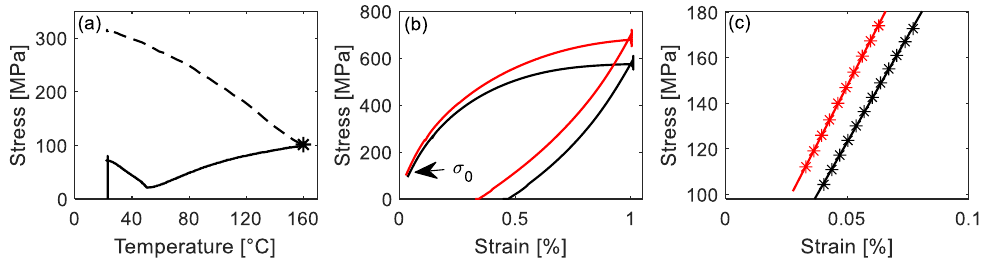
Figure 12. ( a ) Stress vs. temperature up to the target temperature (The dashed line shows the expected path for full activation). The black star (50 ◦ C ↑ ) marks the point, at which E SMA was evaluated. ( b ) Stress-strain curve to determine the E SMA ( κ ). ( c ) The linear fitting (regression line) in the stress range from σ 0 + 5 to σ 0 + 80 MPa. Red and black lines in ( b , c ) represent the specimen pre-strained to 4% and 2%,